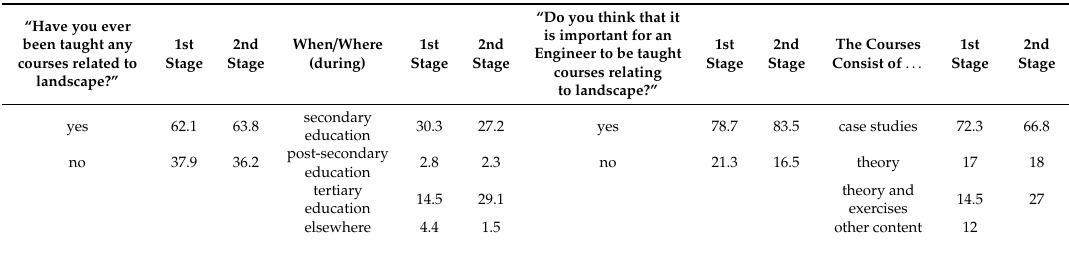
Table 3. Importance of landscape courses taught, according to Greek engineering students (1st and 2nd research stages).